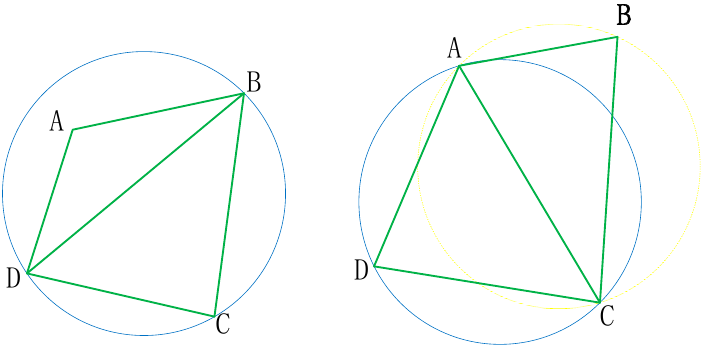
Figure 7. The LOP processing process.